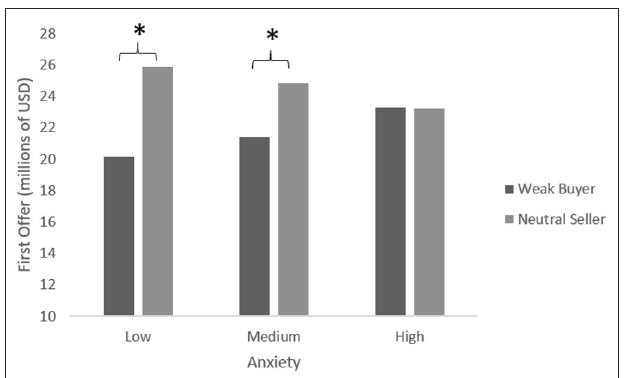
FIGURE 3 | Mean first offer—differing levels of anxiety. * p <